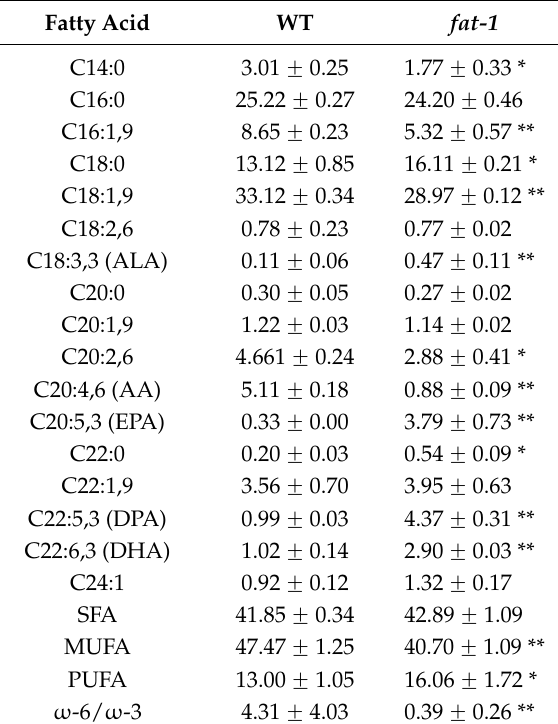
Table 1. Profiles of polyunsaturated fatty acid of primary cortical neurons derived from fat-1 transgenic embryos and their WT